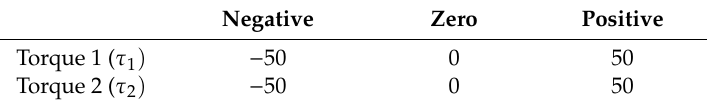
Table 8. Sugeno coe ffi cients.